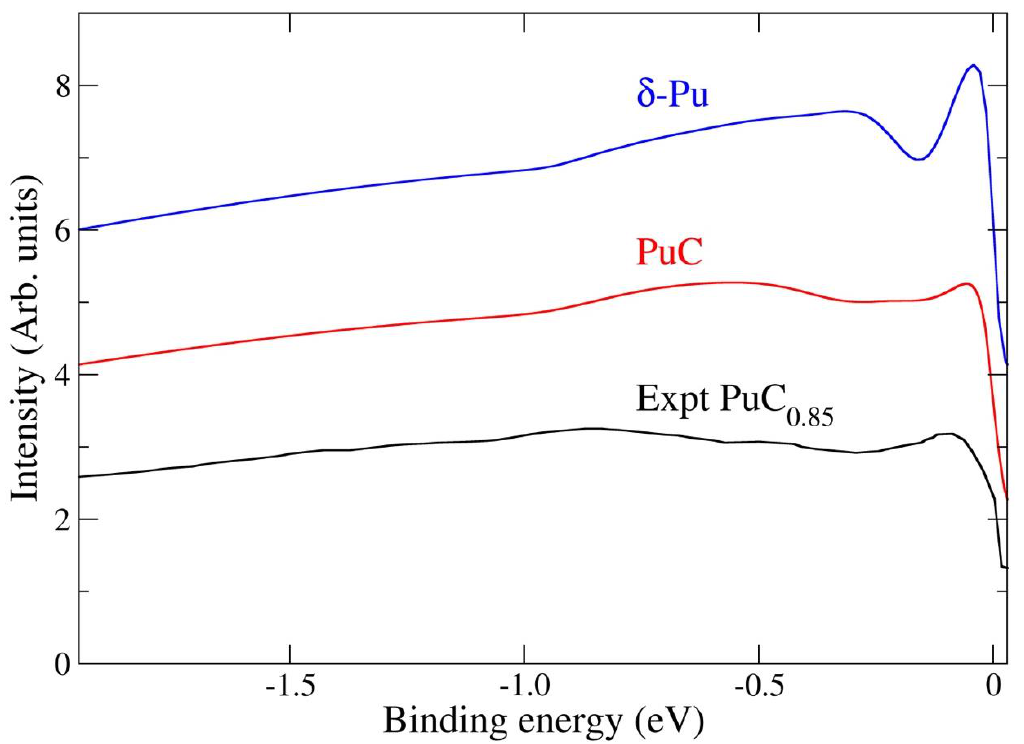
Figure 3. Total electronic density of states, from our best theory (DFT + SO + OP) for PuC (red) and δ -Pu (blue) that have been convoluted due to instrumental resolution and photon lifetime broadening. The experimental data points for PuC 0.85 are from photoemission (40.81 eV photon energies) by Gouder et al. [49] and the simulation for δ -Pu is reproduced from reference [50]. The curves are arbitrarily shifted relative to each other to make the plot more readable.